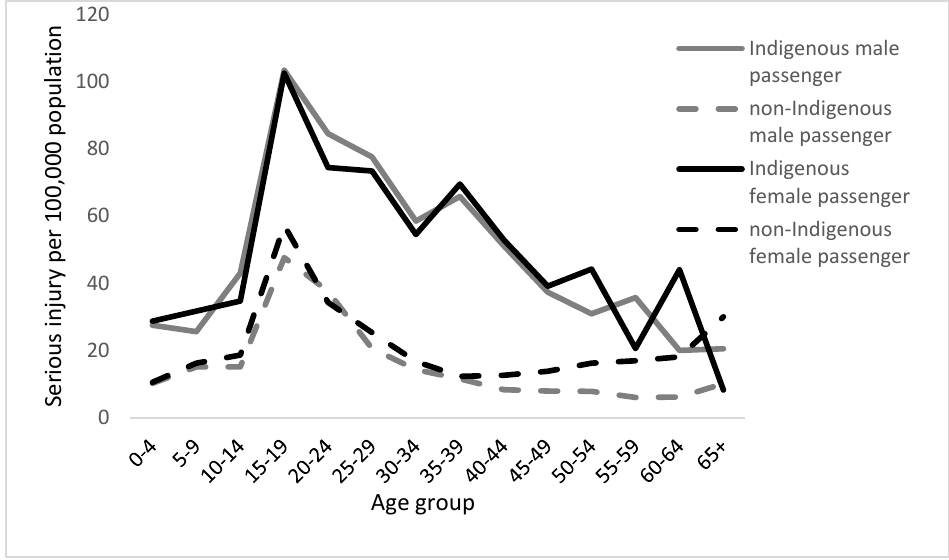
Figure 1. Age-specific rates of serious injury to male and female Indigenous and non-Indigenous passengers from 2005 – 2006 to 2009 – 2010 in Western Australia. Adapted from [37].